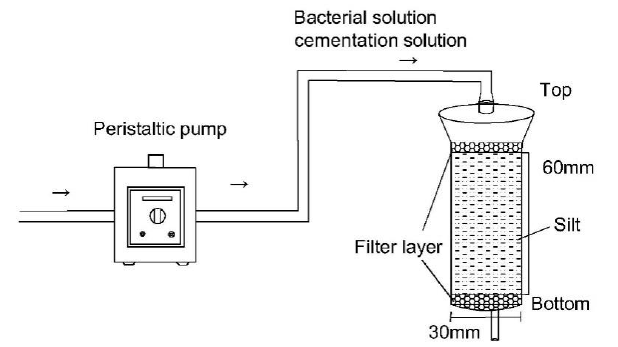
Figure 3. Grouting device.